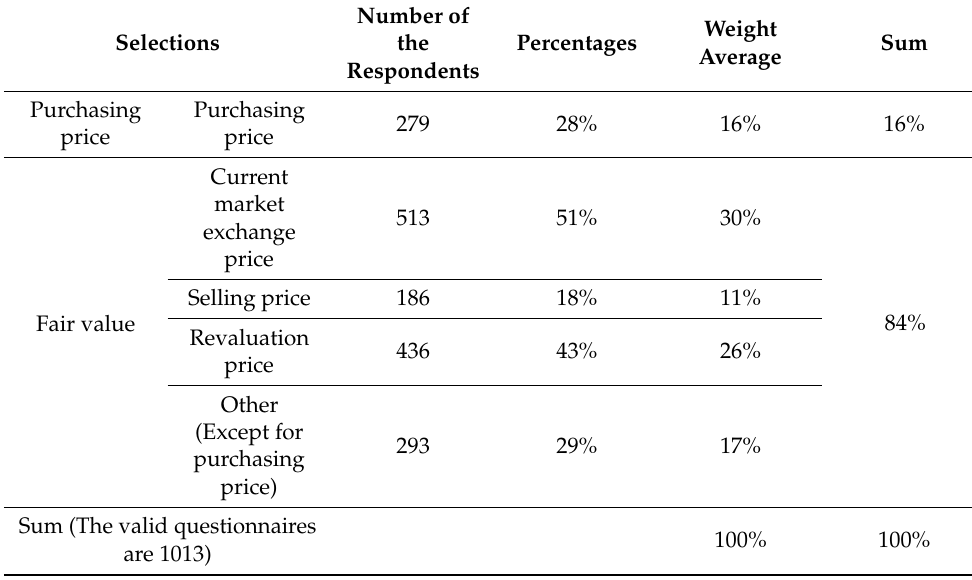
Table A10. How to disclose the values of cryptocurrencies in accounting (multiple-choice question)?